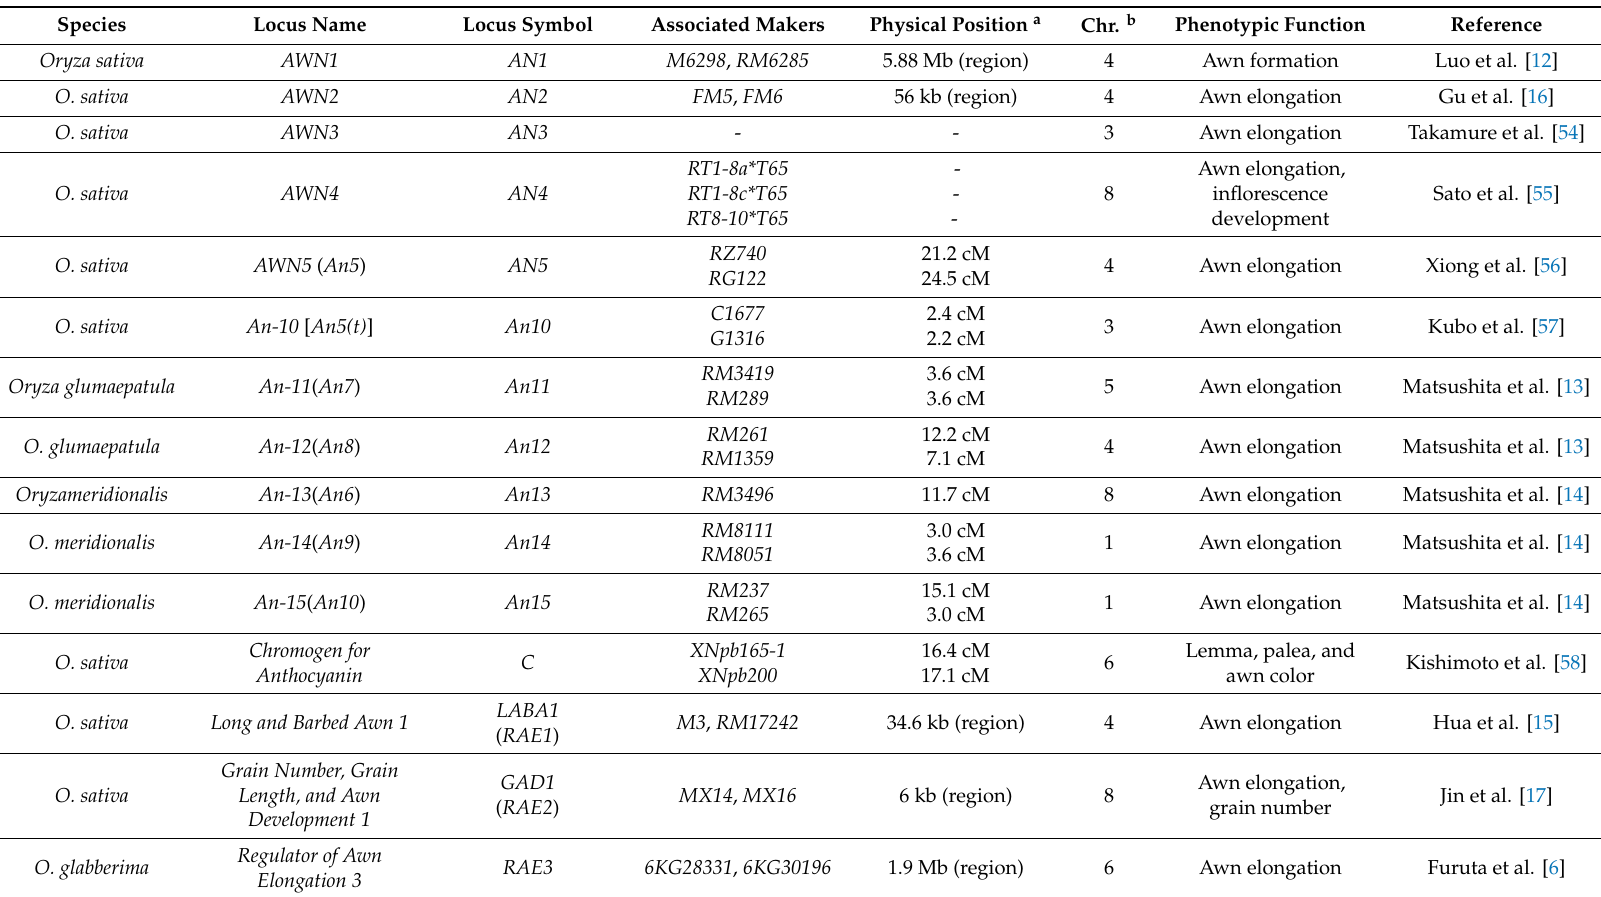
Table 1. Genes that underlie awn development in major grass